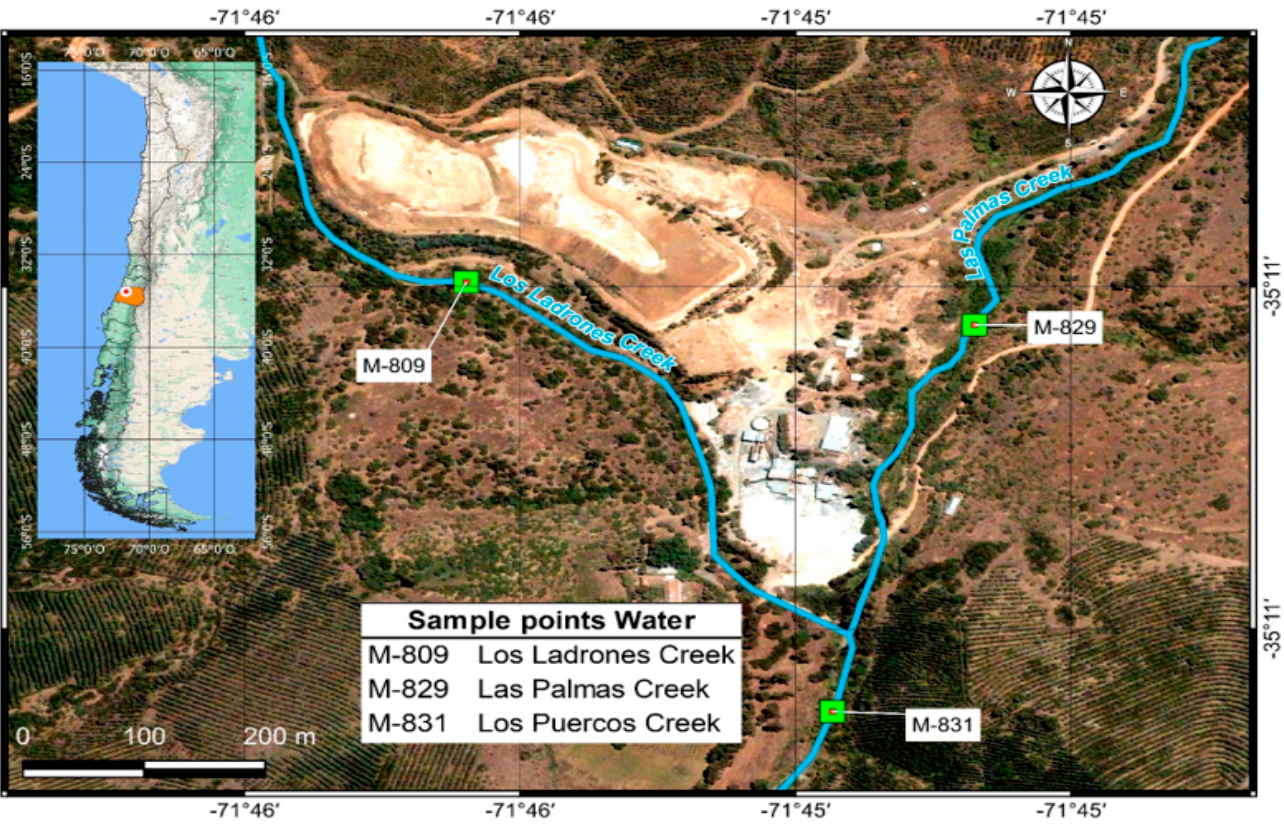
Figure 16. Area affected by mining tailings spill Las Palmas creek, water sampling (Modified from [63]).